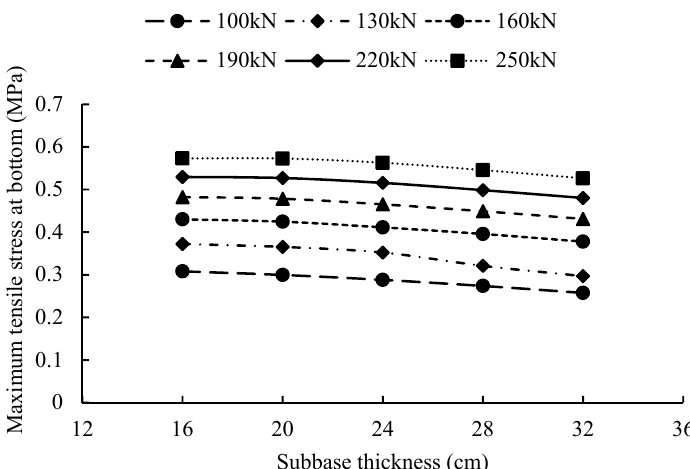
Figure 7. Relationship between bottom base thickness and maximum tensile stress at the bottom layer.